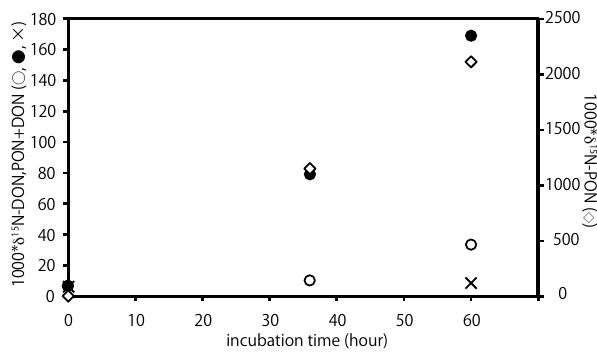
Fig. 1. Variations in δ 15 N values for each fraction in an incuba- tion bottle (5-m depth/KH06-2 Stn. 5) plotted as a function of the incubation period. The diamonds ( (cid:5) ) indicate the δ 15 N values of particulate with 15 N 2 (right axis), open circles ( ◦ ) indicate filtrate with 15 N 2 (left axis), closed circles ( • ) indicate particulate + filtrate with 15 N 2 (left axis) and crosses ( × ) indicate filtrate without 15 N 2 (left axis). All error bars were smaller than symbols.